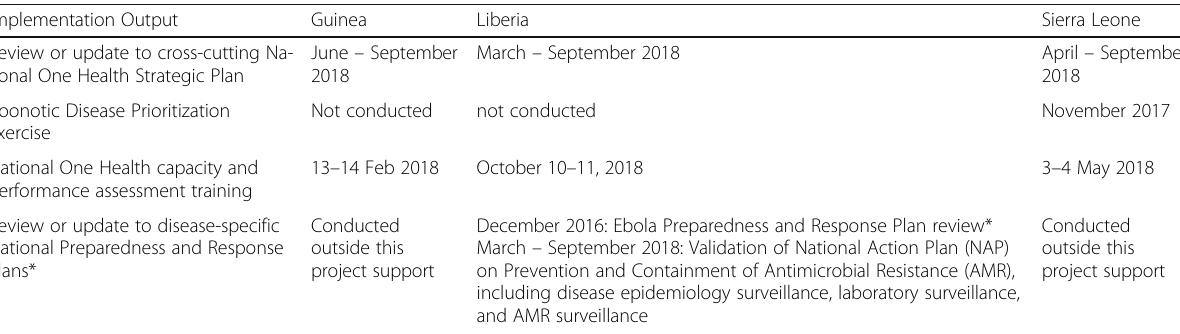
Table 4 Key One Health Implementation Outputs by January 2019 in Guinea, Liberia, and Sierra Leone Implementation Output